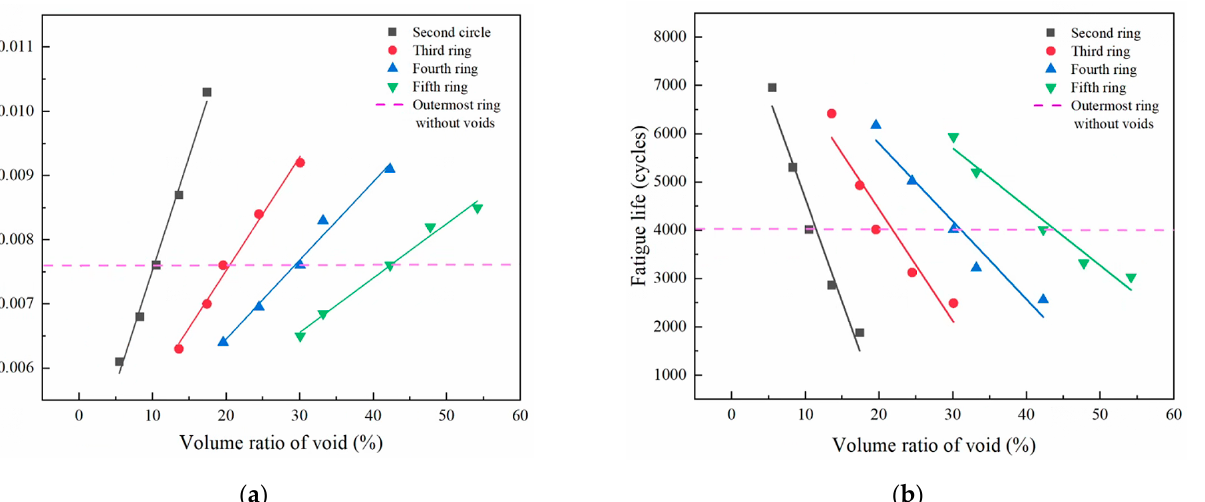
Figure 10. The relationship between ( a ) void content and accumulated equivalent plastic strain in a single circle and( b ) void content and fatigue life of solder balls.